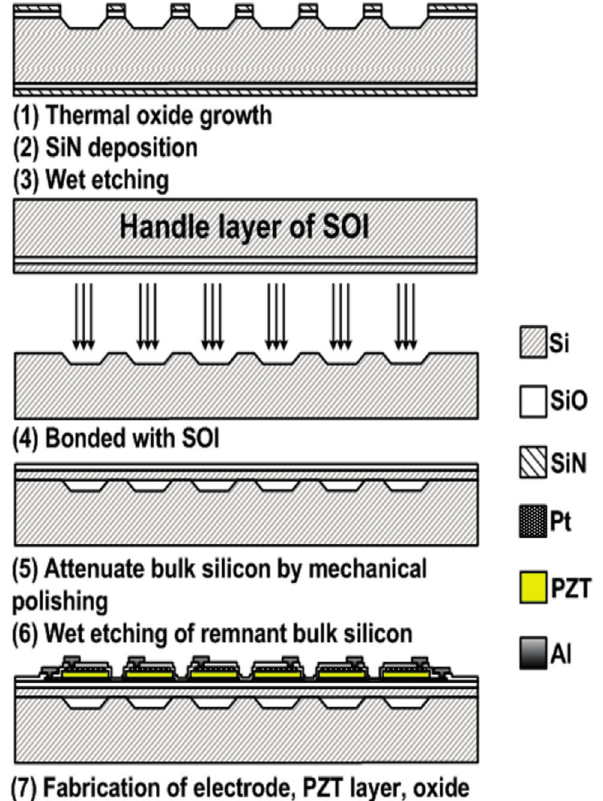
Figure 7. Fabrication process flow of PMUTs with diaphragms formed by reverse bonding